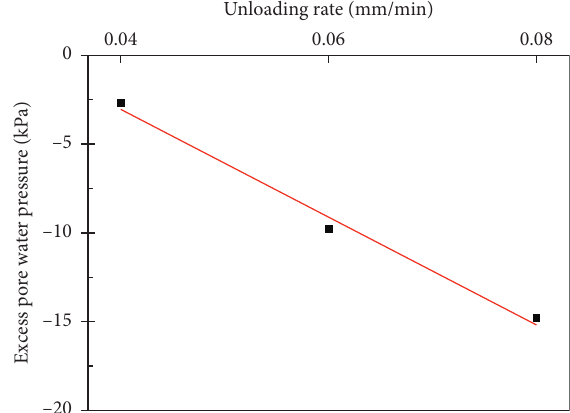
Figure 11: Curve of excess pore water pressure with unloading rate under confining pressure of 121kPa.